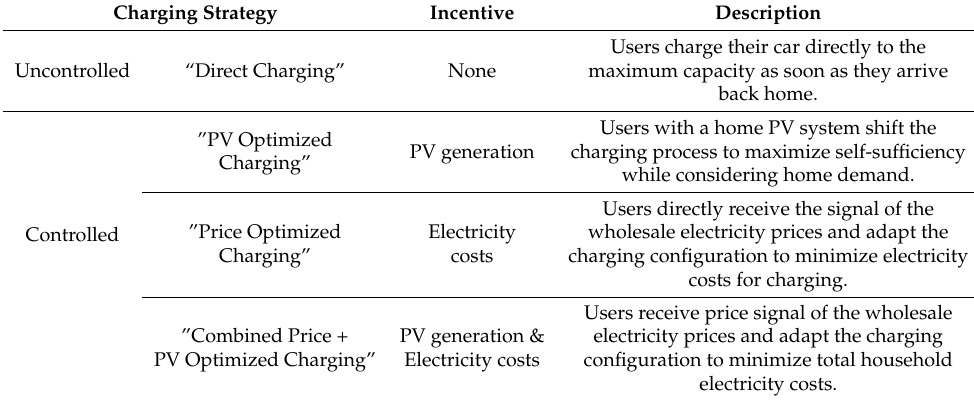
Table 1. Overview of the considered charging strategies.